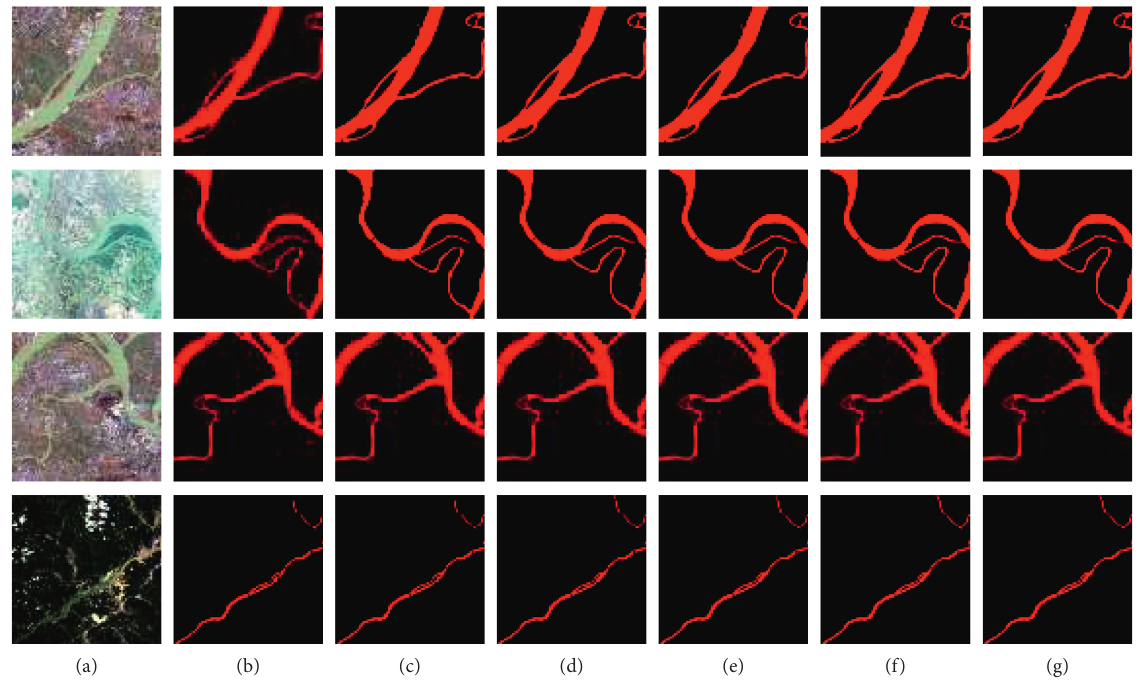
Figure 12: Comparison of effects of different networks. (a) Real image. (b) FCN-8s. (c) SegNet. (d) BiSeNet. (e) U-Net. (f) D-LinkNet. (g) CoANet.